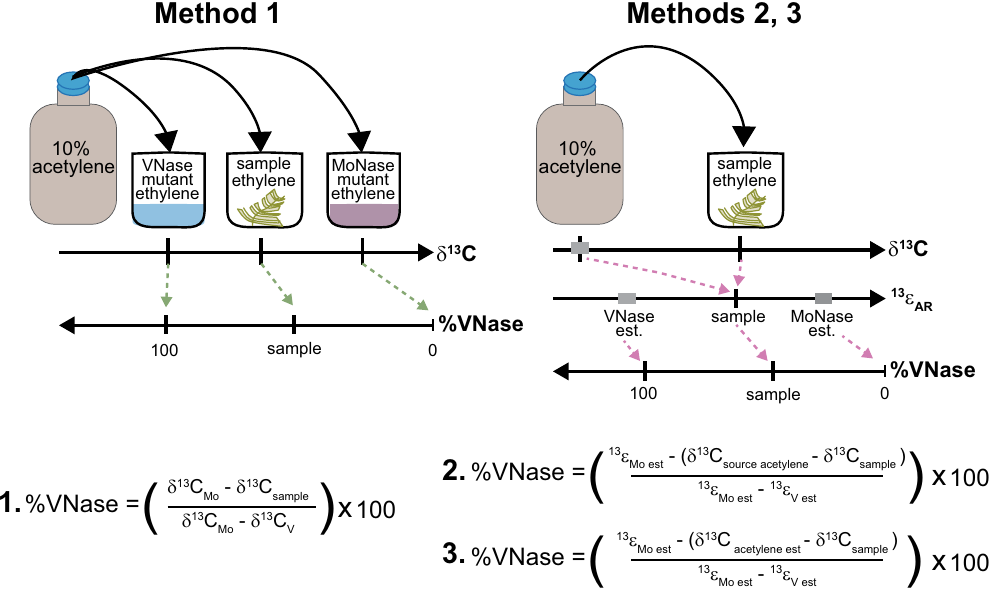
Figure 2. Overview of direct δ 13 C ethylene and 13 ε AR (= δ 13 C source acetylene – δ 13 C ethylene ) scaling methods for converting sample δ 13 C ethylene values to percent acetylene reduction by V-nitrogenase (%VNase). In the direct scaling method 1, the same batch of source acetylene is used in ARA incubations of Azotobacter mutants expressing only Mo or VNase as for the environmental samples, precluding the need to measure δ 13 C source acetylene and enabling %VNase to be calculated based solely on δ 13 C ethylene . Following 13 ε AR scaling methods 12 , different batches of acetylene can be used for sample and single nitrogenase calibration (e.g., mutant) ARAs; measured 13 C 13 C (method 2) or estimated (method 3) values of source acetylene along with measured δ ethylene for each batch of ARAs are used to calculate 13 ε AR values, which are then converted to %VNase by comparison with 13 ε Mo and 13 ε v . ẟ See Method section above and Supplementary Methods S5 online for equation